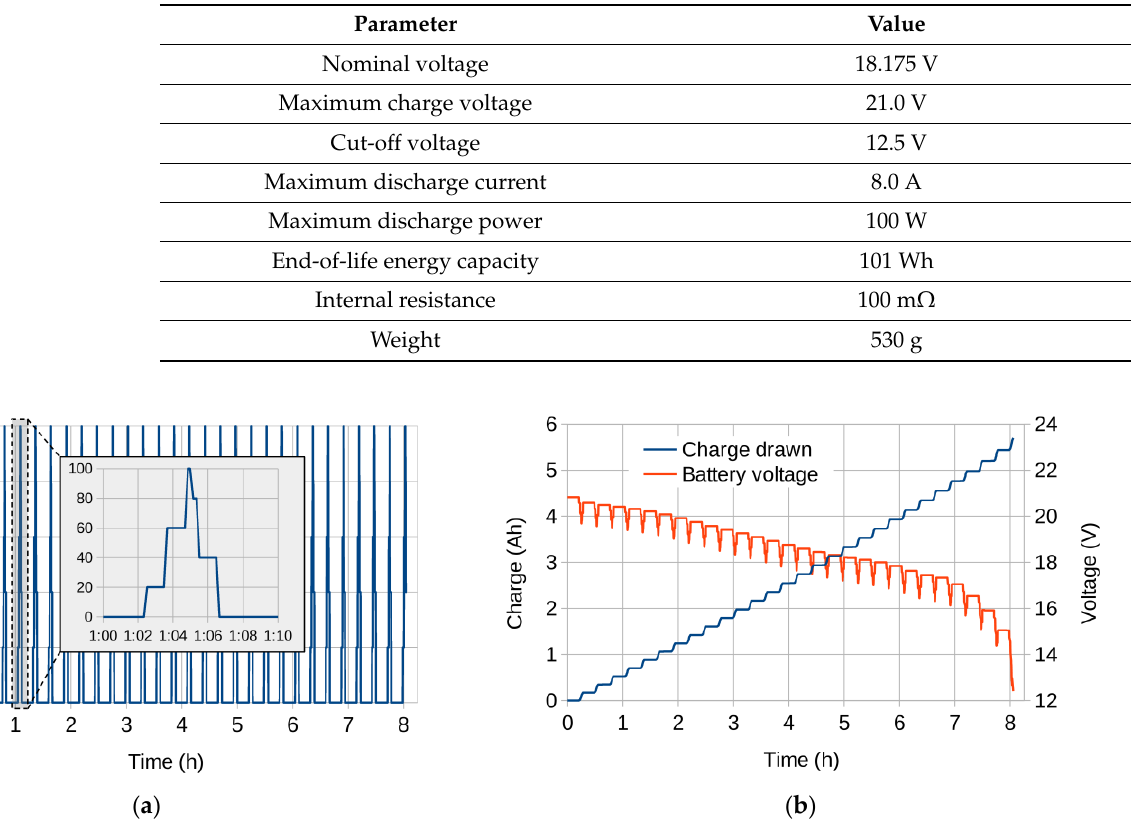
Figure 5. Battery pack operating characteristics as obtained with the developed model in the as- sumed real use case: ( a ) Heating power profile; ( b ) Charge drawn from the battery pack and battery pack